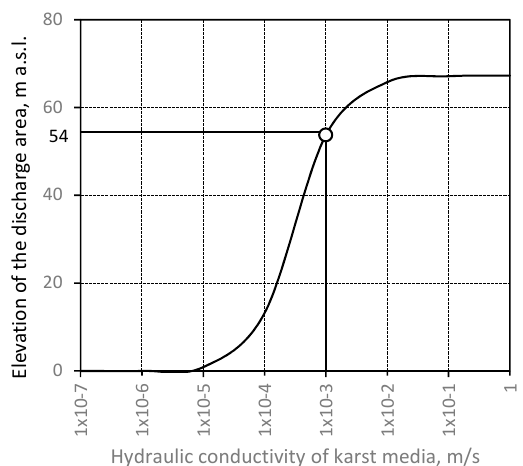
Figure 10. Relationship between hydraulic conductivity of karst media and discharge area elevation; The Rio Grassano elevation (54 m a.s.l.) was obtained considering hydraulic conductivity K = 0.001 m/s.